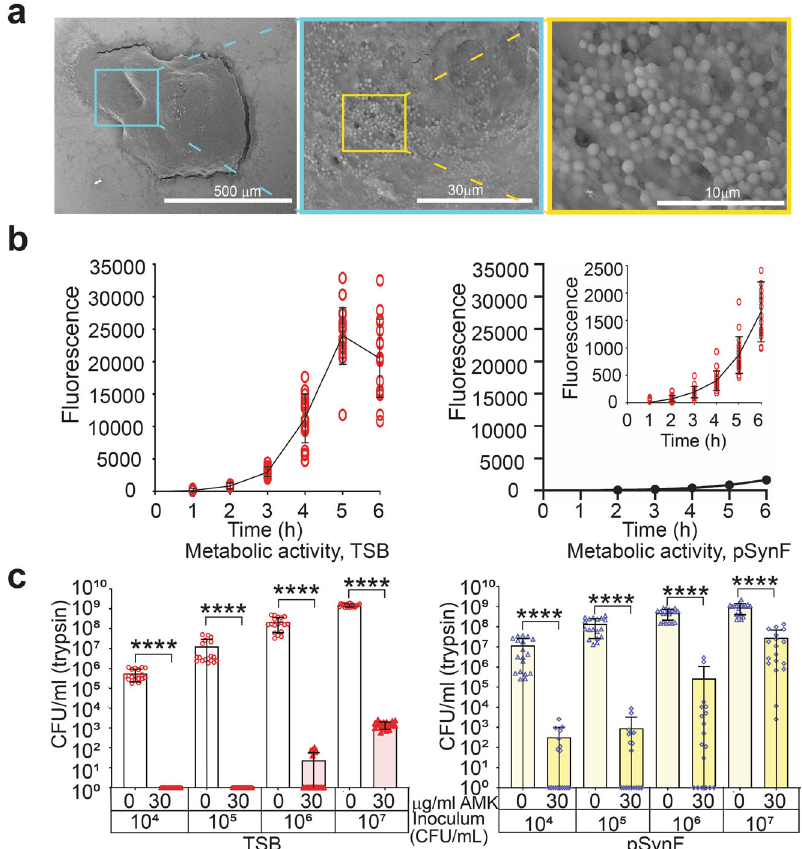
Fig. 1 S. aureus aggregates in pSynF are metabolically suppressed and exhibit tolerance to amikacin. a Scanning electron micrographs of an S. aureus aggregate formed in a model SynF, i.e., pSynF. Successive magni fi cations are indicated and highlight the bacteria covered in matrix. b Alamar blue fl uorescence as an indicator of S. aureus metabolic activity in TSB and pSynF (inset shows an expansion of the y-axis). Note the >10× suppression in metabolic activity in pSynF. c S. aureus sensitivity to 30 µ g/mL of AMK as a function of initial inoculum and of culturing in TSB or pSynF. Notably, bacterial survival is apparent even at the lowest inoculum when cultured in pSynF. Data presented as mean ± standard deviation. For each point b or bar c , n = 18. Individual data points are shown as open, colored symbols. Normality checked using Kolmogorov – Smirnov test. Comparisons done using two-tailed Wilcoxon rank sum test. **** P <